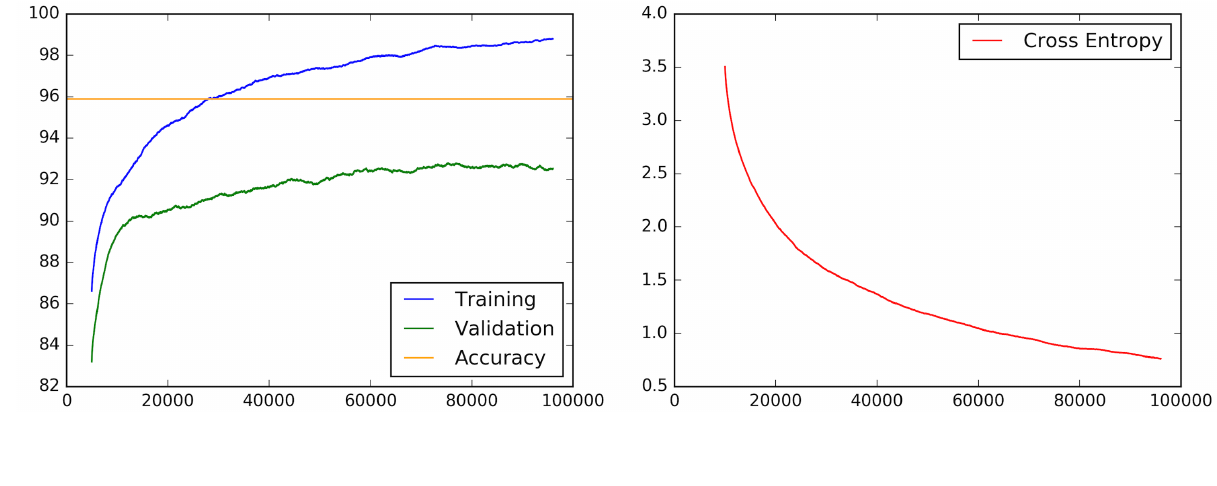
Figure 8. Training (blue) and validation (green) accuracy during training phase, with final accuracy (orange) and cross entropy (red) for 96,000